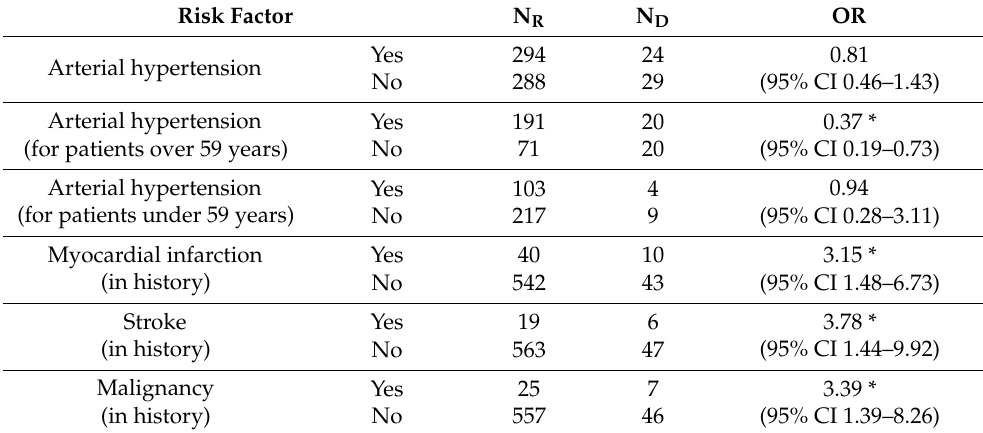
Table 3. Summary of key findings in analysis of comorbidities as a risk